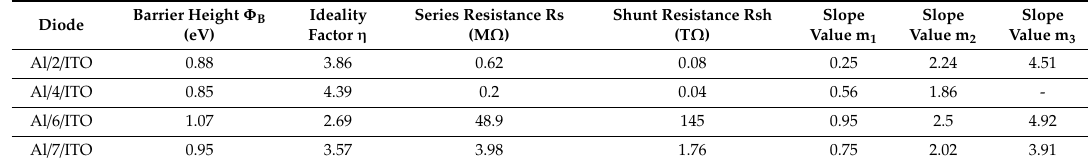
Table 2. Diode parameters of the Al / Zncomplex / ITO (Indium tin